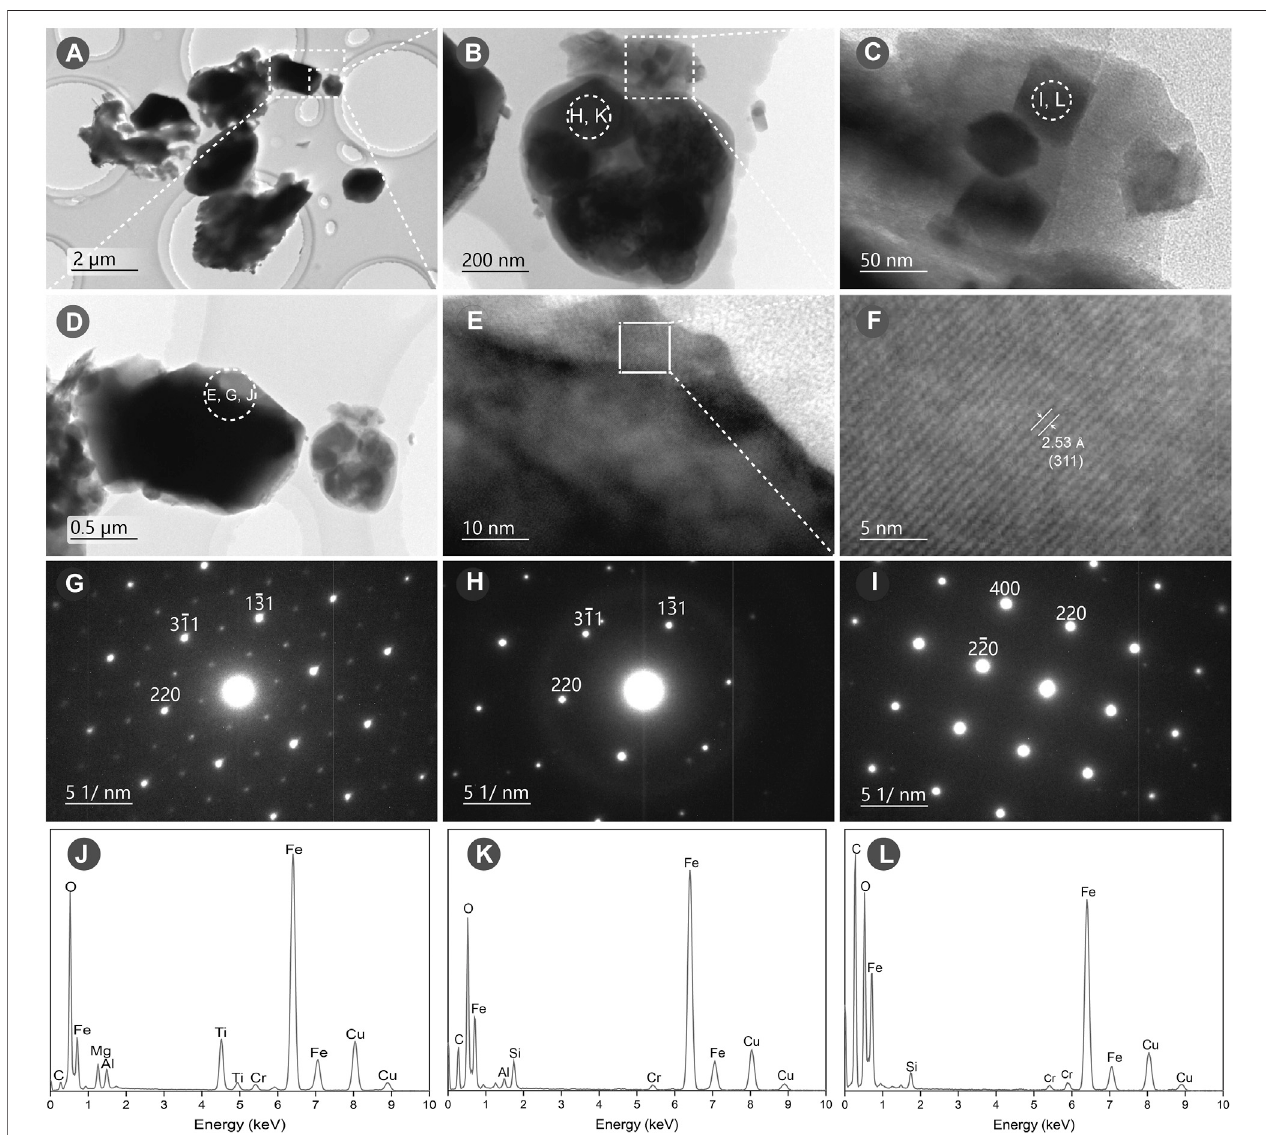
FIGURE6| High-resolutionTEMand SAED analyses ofmagneticminerals for magnetic extracts from limestones inthe Zongpu Formation. (A – D) Bright- fi eld TEM images at progressively higher magni fi cations reveal characteristics of mixed magnetic particles with different sizes. (E,F) Clear lattice fringes for the magnetic minerals are observed. The lattice fringes in (F) correspond to < 311 > plane of titanomagnetite. (G – I) Ring-like and spot-like SAED patterns indicate the particle aggregate and single particle, respectively. The corresponding Miller indices (hkl) are illustrated. (J – L) EDS spectra of the magnetic particles in B-D. The particles in different sizes are magnetite (B,C) and titanomagnetite (D)